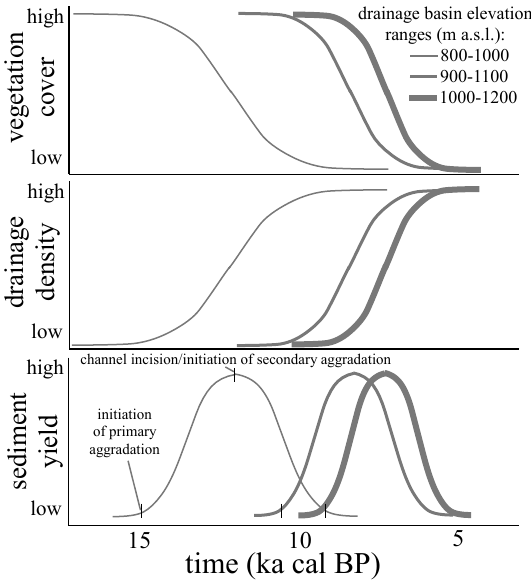
Figure 9. Conceptual model illustrating relationships among veg- etation cover, drainage density, and sediment yield from source catchments for three hypothetical catchments (each with 200m of relief) of different mean